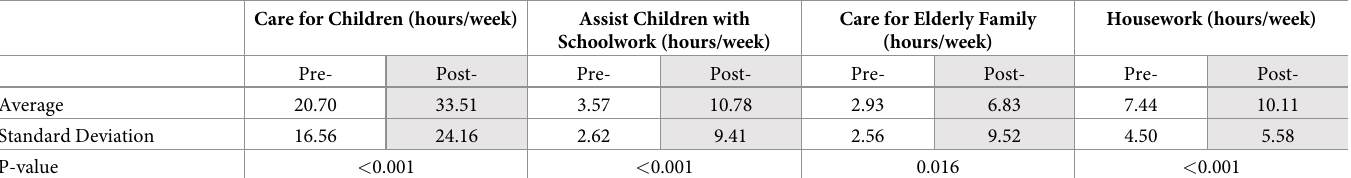
Table 4. Reported number of hours per week spent caring for children, assisting with schoolwork, caring for elderly family members and housework pre- and post- COVID-19 for all subjects. Care for Children